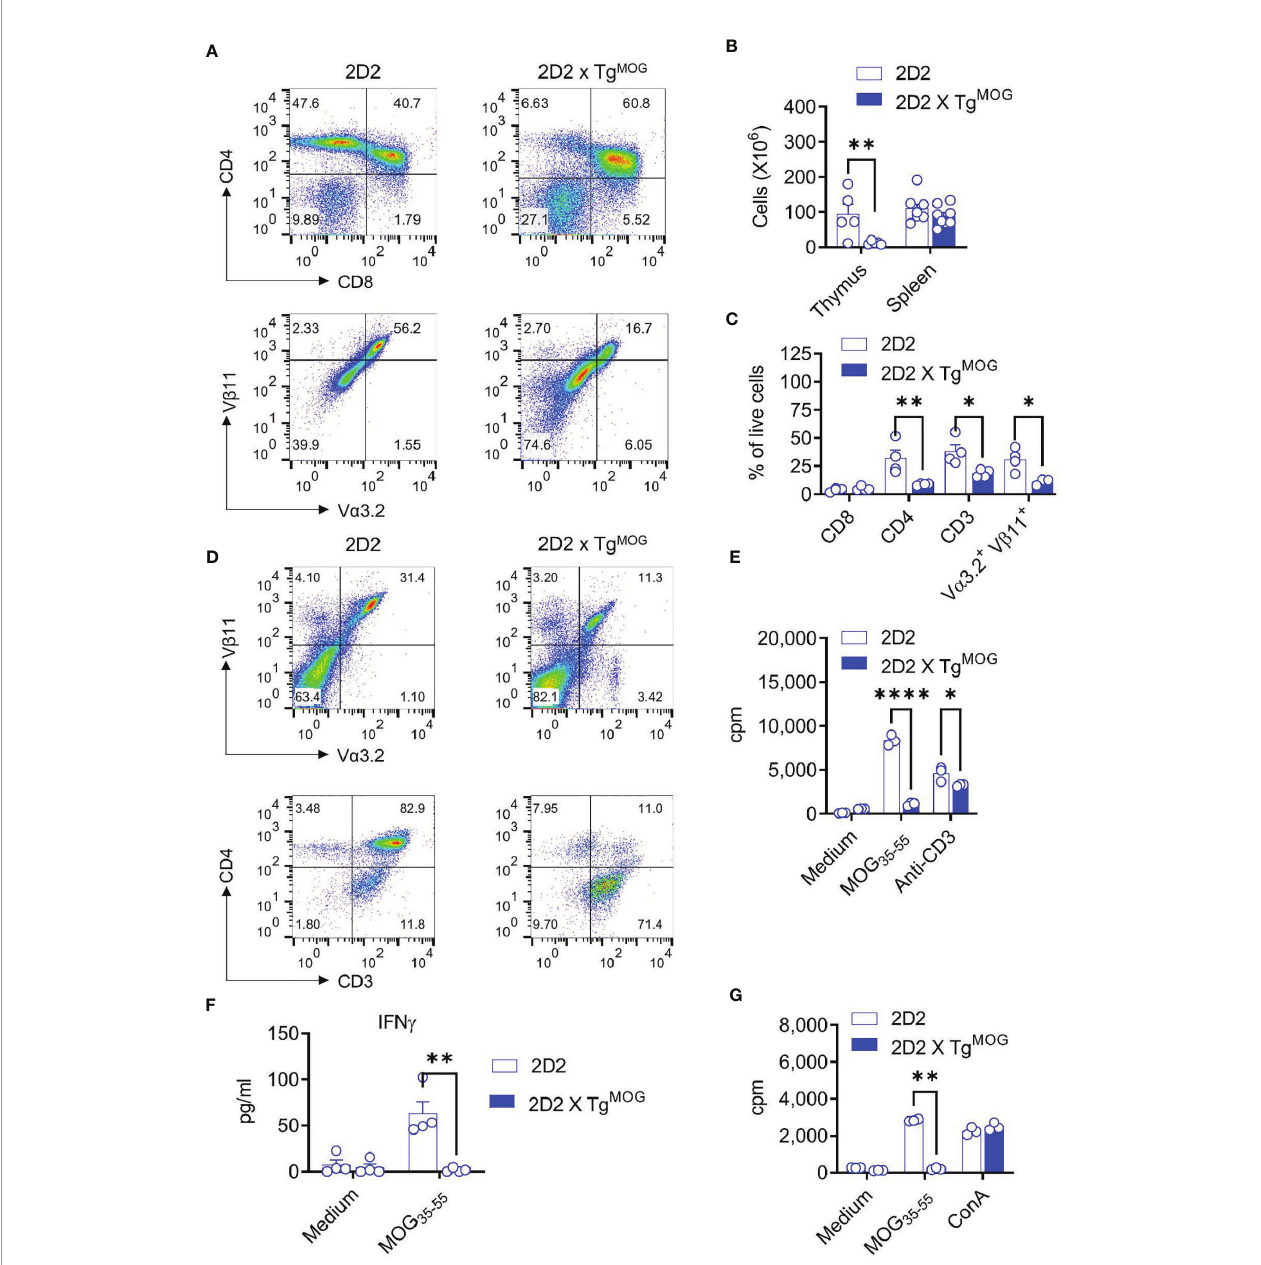
FIGURE 5 | MOG-speci fi c CD4 + T cell - tolerance in 2D2 x Tg MOG mice. (A) , Flow cytometry analysis of thymus from 2D2 and 2D2 X Tg MOG littermates. Representative plots are shown. (B) , Cellularity of thymus and spleen from 2D2 and 2D2 X Tg MOG littermates. The combined data from two independent experiments is shown. Each circle represents an individual mouse. n = 5 - 8 mice per group. **P = 0.0021 (Two-way ANOVA). (C) , Immune cell composition of the spleen from 2D2 and 2D2 X Tg MOG mice. Frequencies of CD4 + , CD8 + , CD3 + , and transgenic TCR V a 3.2 + V b 11 + cells in the live gate are shown. Representative data from two independent experiments is shown. Each circle represents an individual mouse. n = 3 – 4 mice per group. **P = 0.0037, *P < 0.02 (Two-way ANOVA). (D) , Analysis of CD4 and CD3 expression in transgenic TCR V a 3.2 + V b 11 + cells. Representative data from more than two independent experiments is shown. (E) , Proliferation of splenocytes from 2D2 and 2D2 X Tg MOG mice. Representative data from two independent experiments is shown. Each circle represents an individual replicate. ****P < 0.0001, *P = 0.0223 (Two-way ANOVA). (F) , IFN g secretion by splenocytes in response to MOG 35-55 . Representative data from two independent experiments is shown. Each circle represents an individual mouse. n = 4 per group. **P = 0.0026 (Two-way ANOVA). (G) , Proliferation of splenocytes from MOG 35-55 immunized 2D2 and 2D2 X Tg MOG mice. Representative data from two independent experiments is shown. Each circle represents an individual replicate. **P = 0.0012, *P = 0.0348 (Two-way